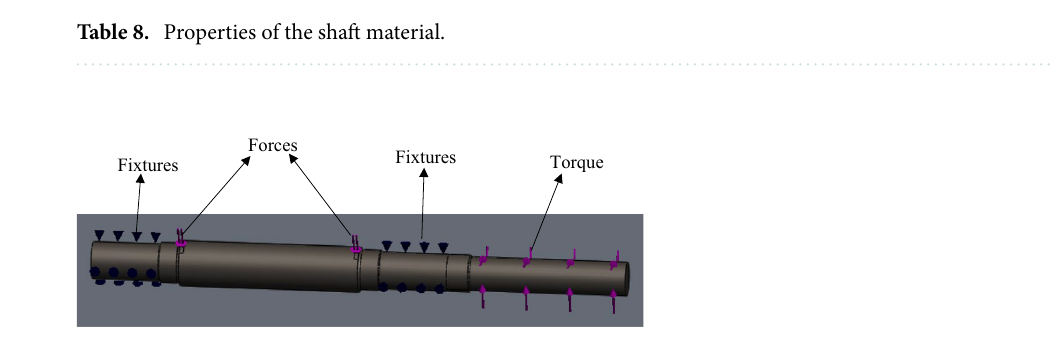
Figure 17. Fixtures and external loads on the shaft